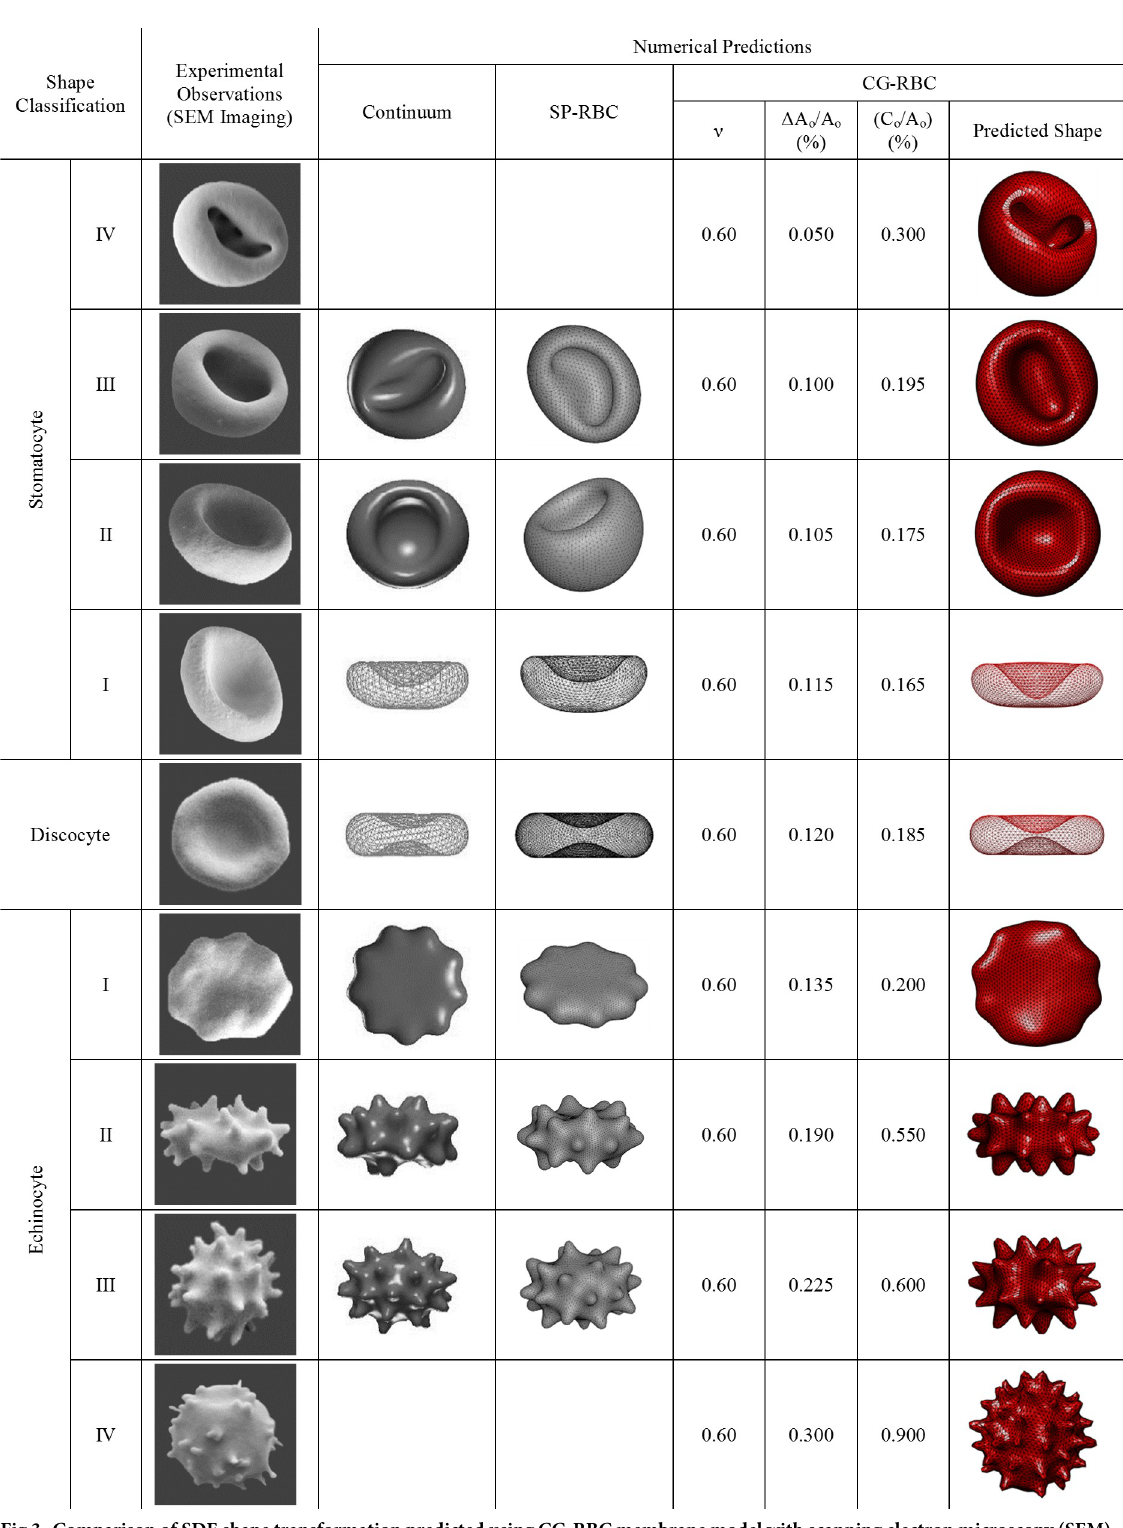
Fig 3. Comparison of SDE shape transformation predicted using CG-RBC membrane model with scanning electron microscopy (SEM) experimental observations and different numerical prediction techniques. The corresponding CG-RBC membrane model parameters of reference reduced cell volume ð n Þ , bilayer-leaflet-area-difference ð D A